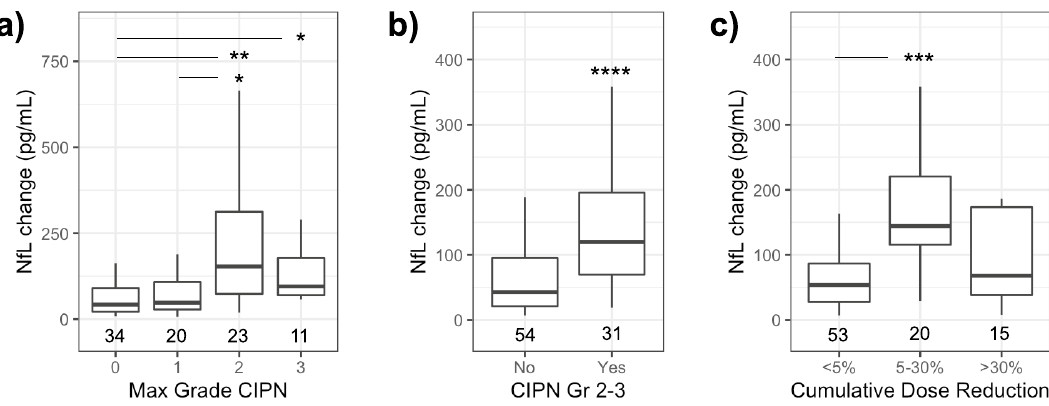
Figure 5. NfL as a predictor of CIPN and paclitaxel dose reduction over duration of the trial. ( a ) Summary of NfL change at C2D1 by highest grade of CIPN reported for all subjects. ( b ) NfL change in subjects that reported grade 2–3 CIPN after C2D1, excluding subjects already reporting such events. ( c ) Reduction of cumulative paclitaxel dose by NfL change * p < 0.05, ** p < 0.01, *** p < 0.001, **** p < 0.0001 by Dunn’s test panel ( a ) and ( c ) or Wilcoxon rank sum test panel ( b ).